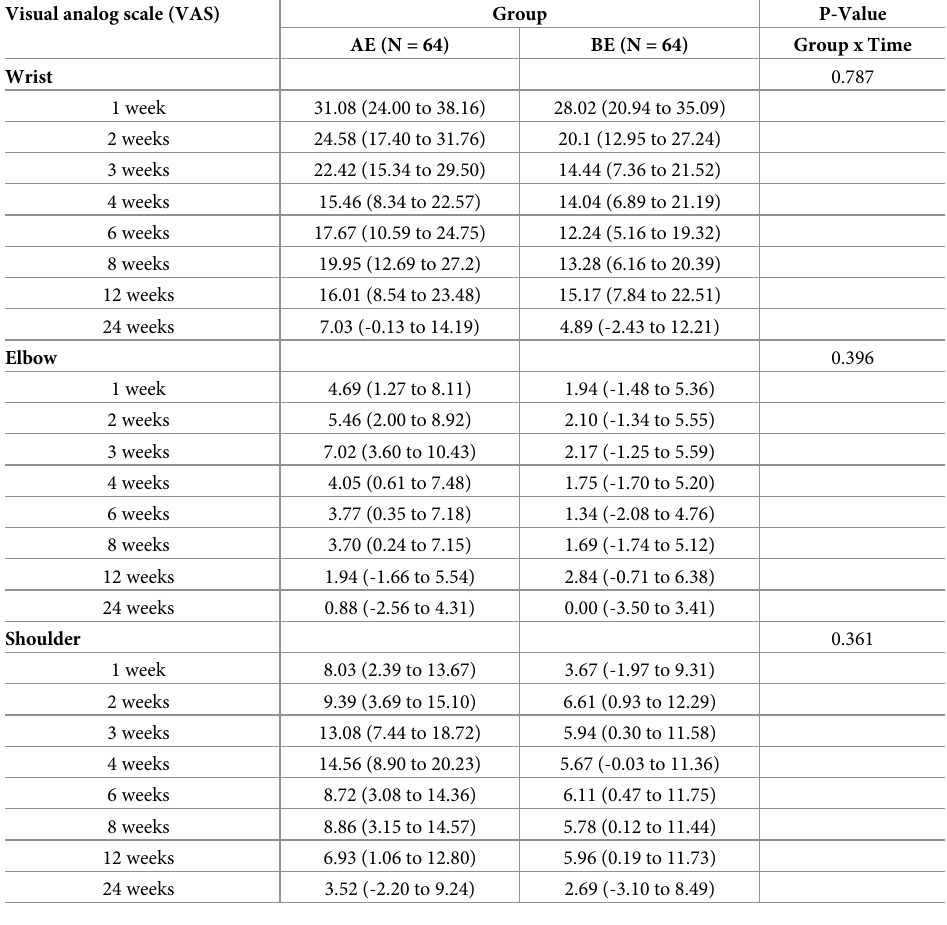
Table 4. Results of pain in wrist, elbow and shoulder by visual analog scale (VAS), show as mean (95%CI). Visual analog scale (VAS) Group P-Value AE (N = 64) BE (N = 64) Group x